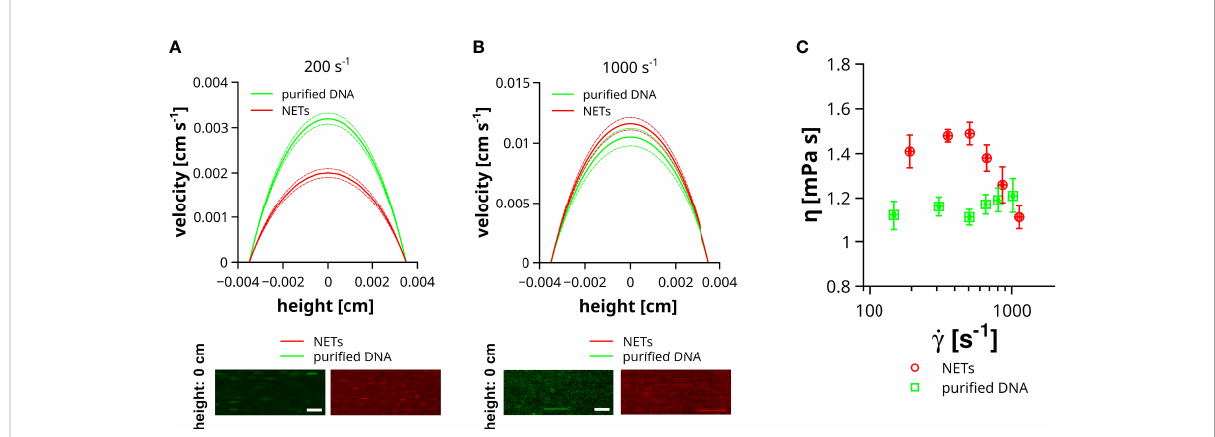
FIGURE 5 Impact of NETs on fl uid viscosity. Velocity (v) of microparticles was measured in channels containing NETs or puri fi ed DNA. Flow experiments were performed at different shear rates ranging from 150 to 1129 s -1 . (A) Representative velocity pro fi les at low shear rates. Image insets show the trajectories of microparticles in the center of the channel (height = 0 cm) either fi lled with fl uid containing puri fi ed DNA (green) or NETs (red). Dashed lines indicate the standard deviation. Exposure time = 10 ms, Scale bar = 50 µm. (B) Representative velocity pro fi les at high shear rates. Image insets show the trajectories of microparticles in the center of the channel (height = 0 cm) either fi lled with fl uid containing puri fi ed DNA (green) or NETs (red). Dashed lines indicate the standard deviation. Exposure time = 1 ms, Scale bar = 50 µm. (C) Shown is the viscosity ( h ) of the fl owing fl uid as a function of the applied shear rate ( g ˙